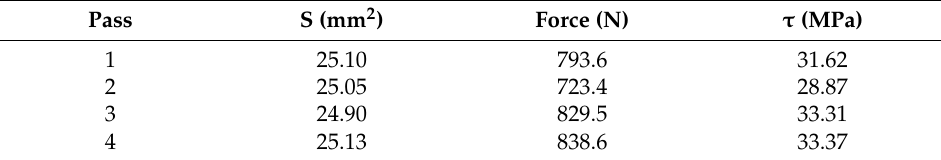
Figure 8. Fracture morphologies and strength of shear specimens: ( a ) fracture morphologies of shear specimens; ( b ) mechanical property curves of shear specimens. Table 3. Shear strength of samples after FSP with different passes.